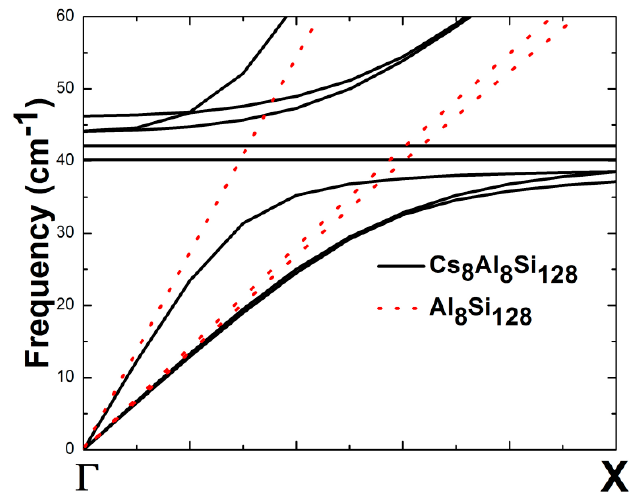
Figure 4. “Avoided-crossing” effect due to encapsulated Cs introduced into Al 8 Si 128 . The solid line shows low-frequency dispersion relation curves of Cs 8 Al 8 Si 128 along the Γ –X direction. Dotted lines give dispersion relation curves of Al 8 Si 128 .